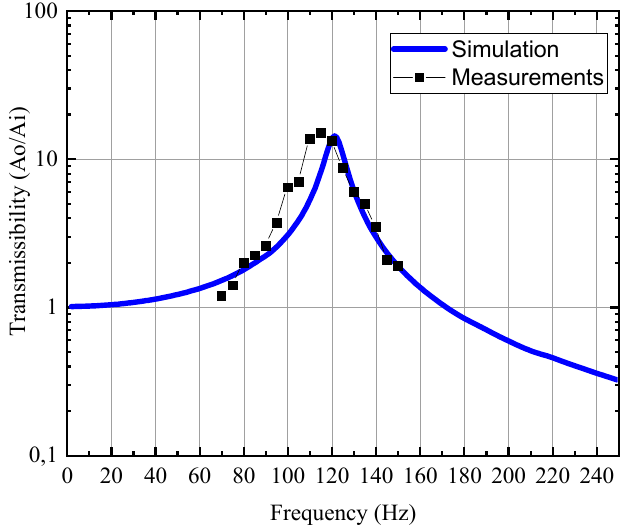
Figure 21. Measured and simulated vertical displacement transmissibility.